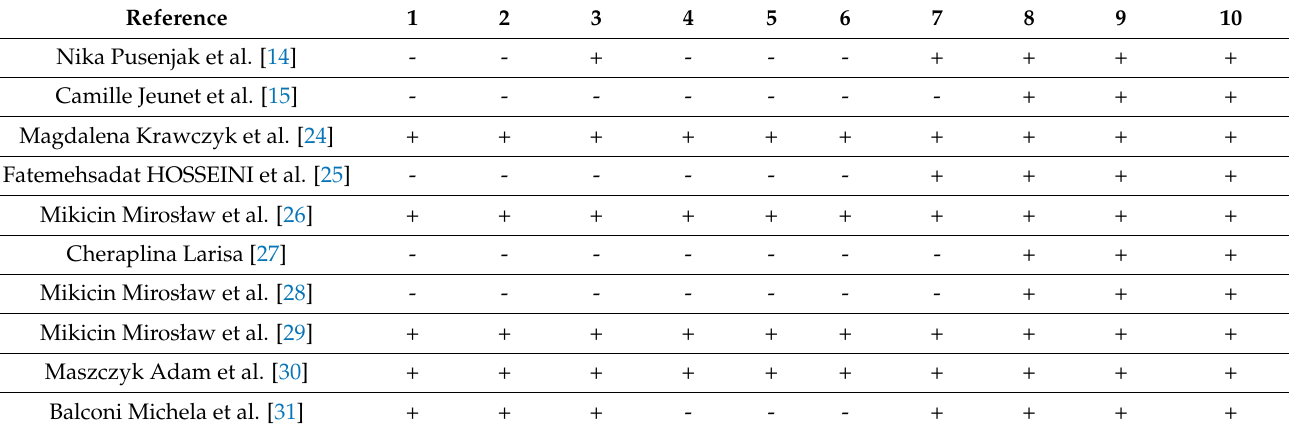
Table 4. PEDro scale for the included